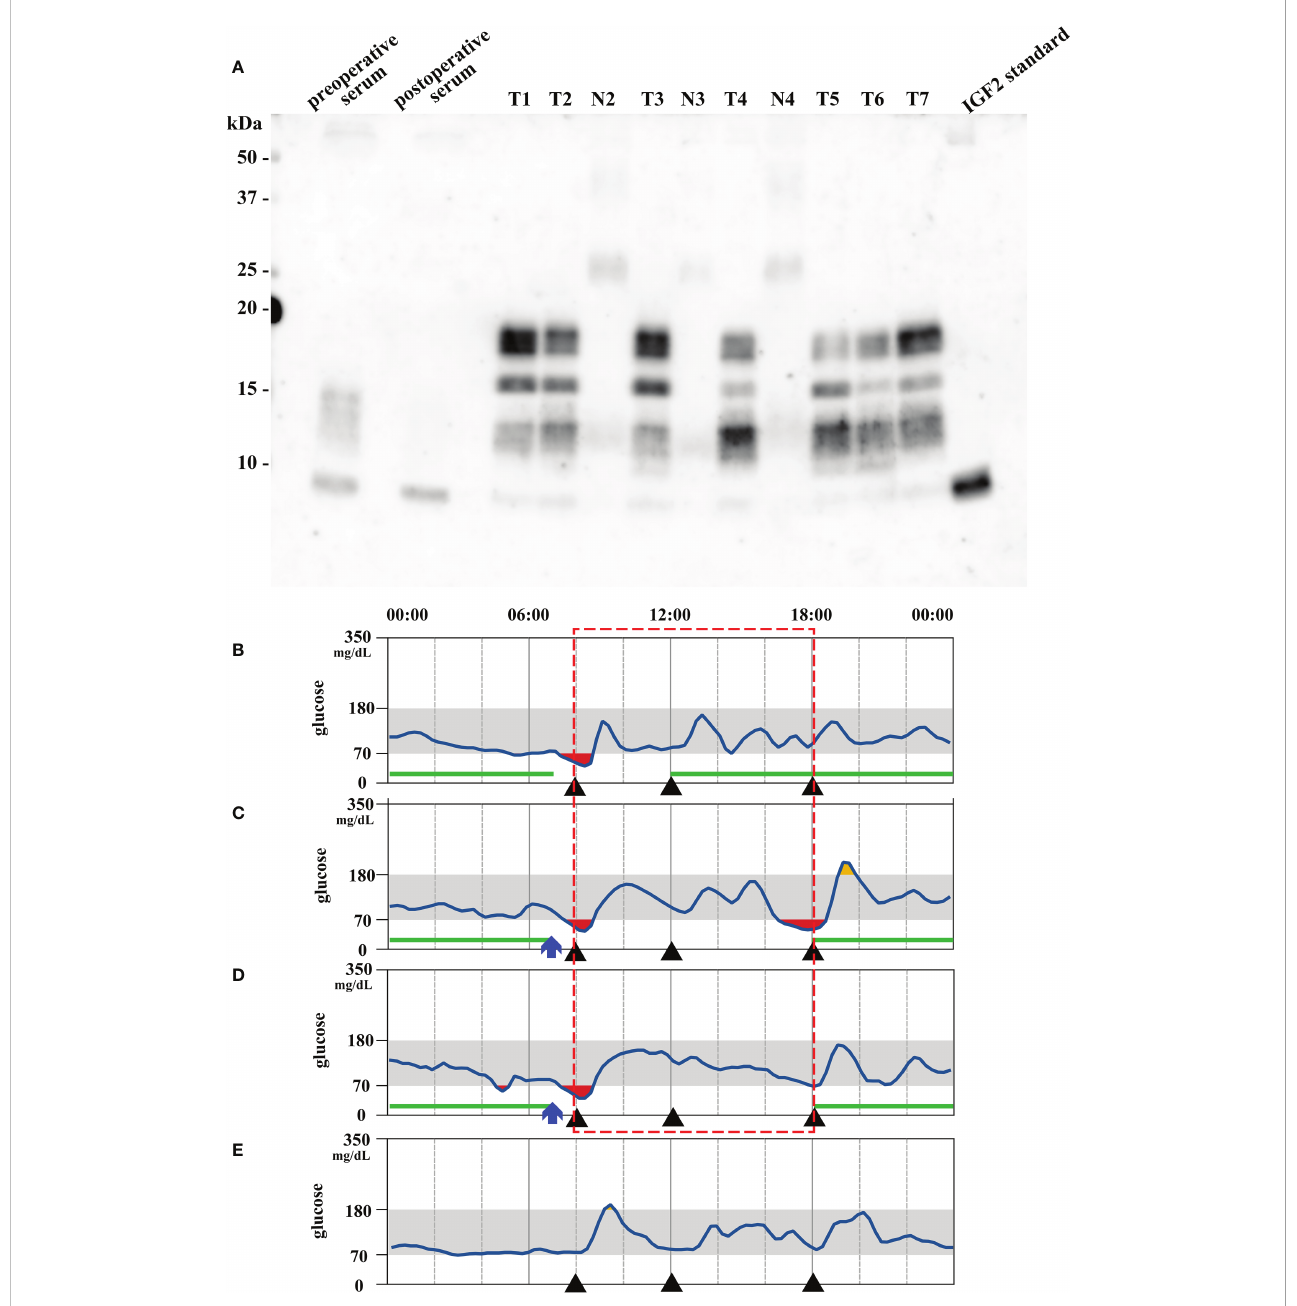
FIGURE 2 (A) Immunoblot analysis of insulin-like growth factor 2 (IGF2) in serum, tumors (T1 – 7 representing tumor #1 – 7) and their nearby normal tissue (N2 – 4 corresponding to tumor #2 – 4). Big IGF2 (11 – 18 kDa) was detected in preoperative serum and all tumor samples. The lane on the right is the IGF2 standard product. T: tumor; N: nearby normal tissue. (B, D) Preoperative and (E) 20 days postoperative continuous glucose monitoring results. (B) Without octreotide administration. (C) 50 m g Octreotide administration at 7 am (blue arrow). (D) 100 m g octreotide administration at 7 am (blue arrow). The red square indicates comparable period of blood glucose levels after octreotide administration. Each black triangle represents meal intake. The green lines indicate the period during which 9 g/h of glucose was intravenously